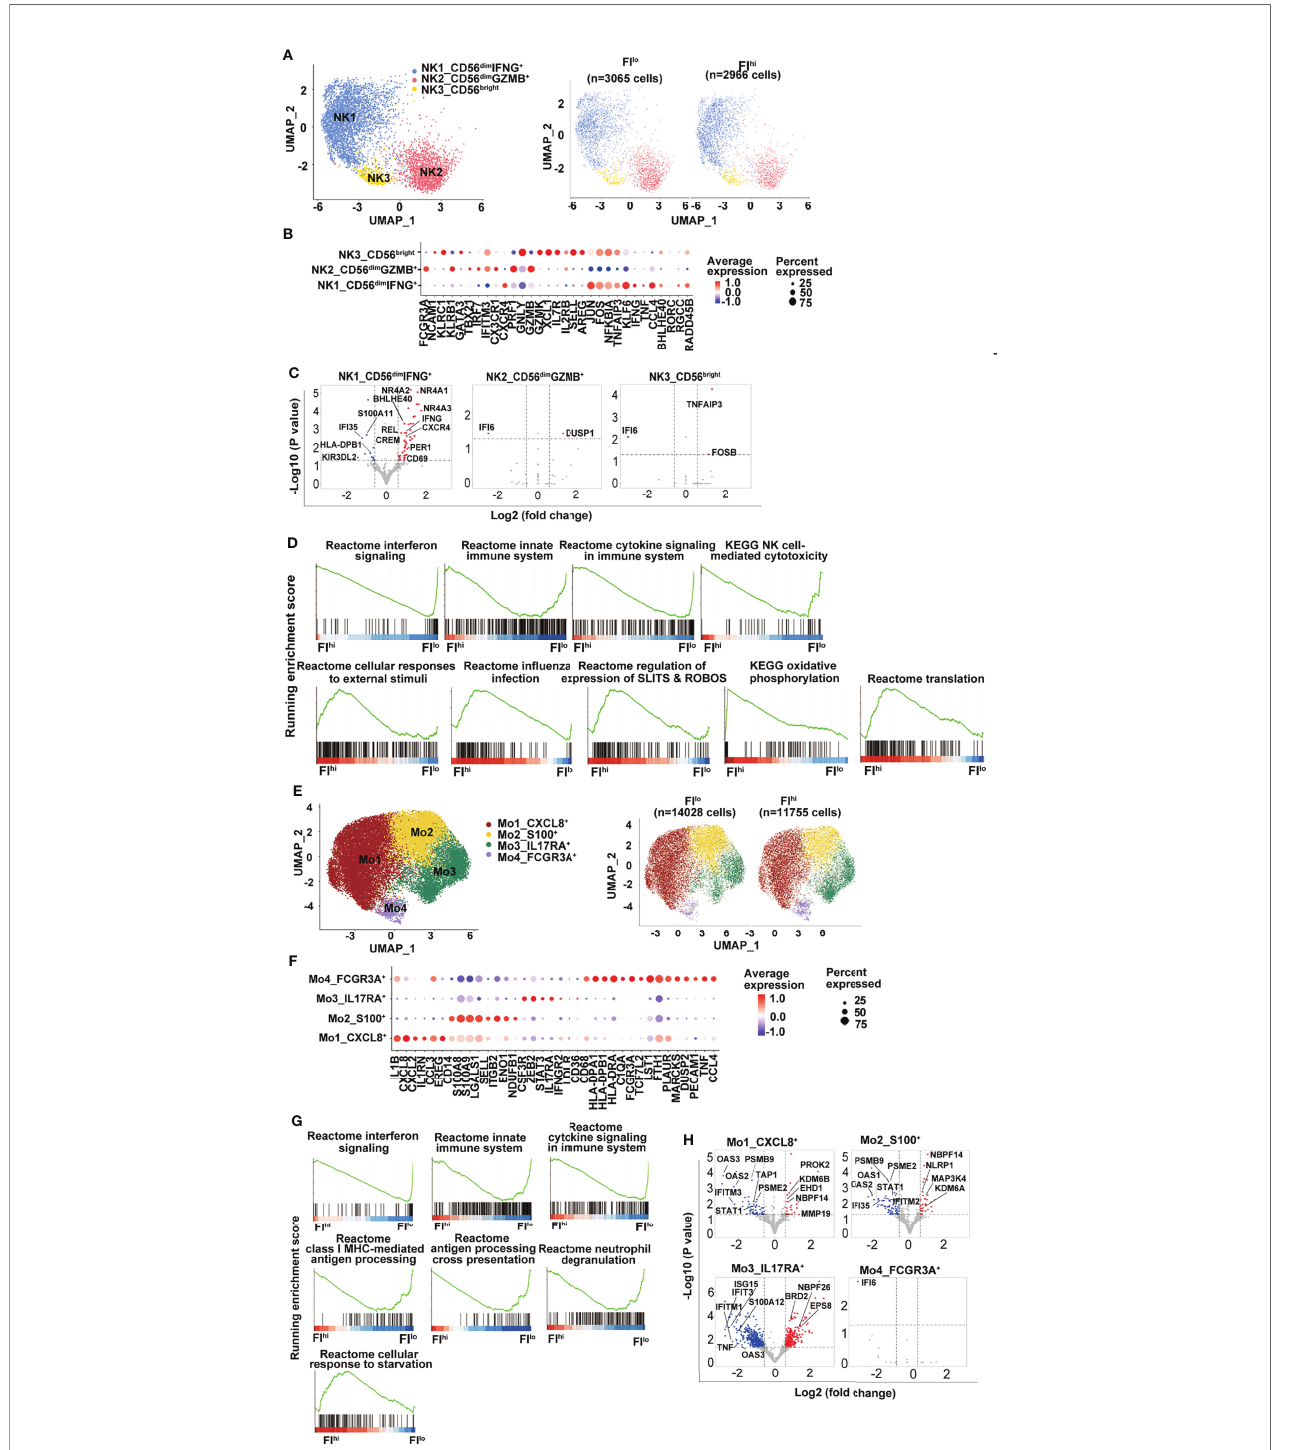
FIGURE 3 | Attenuated global antiviral response in FI hi patients with severe COVID-19. (A) UMAP visualization of NK cell clusters. (B) Heatmap showing the row- scaled expression of selected signature genes for each cluster. (C) Volcano plot showing DEGs ( p -values < 0.05) in the comparison of each NK cell cluster derived from FI lo and FI hi patients. The dot lines show 1.5-fold cutoff. (D) GSEA analysis of DEGs in NK cells in the comparison of FI lo and FI hi patients with severe COVID-19. (E) UMAP visualization of monocyte clusters. (F) Heatmap showing the row-scaled expression of selected signature genes for each cluster. (G) GSEA analysis of DEGs in monocytes in the comparison of FI lo and FI hi patients with severe COVID-19. (H) Volcano plot showing DEGs ( p -values < 0.05) in the comparison of each monocyte cluster derived from FI lo and FI hi patients. The dot lines show 1.5-fold